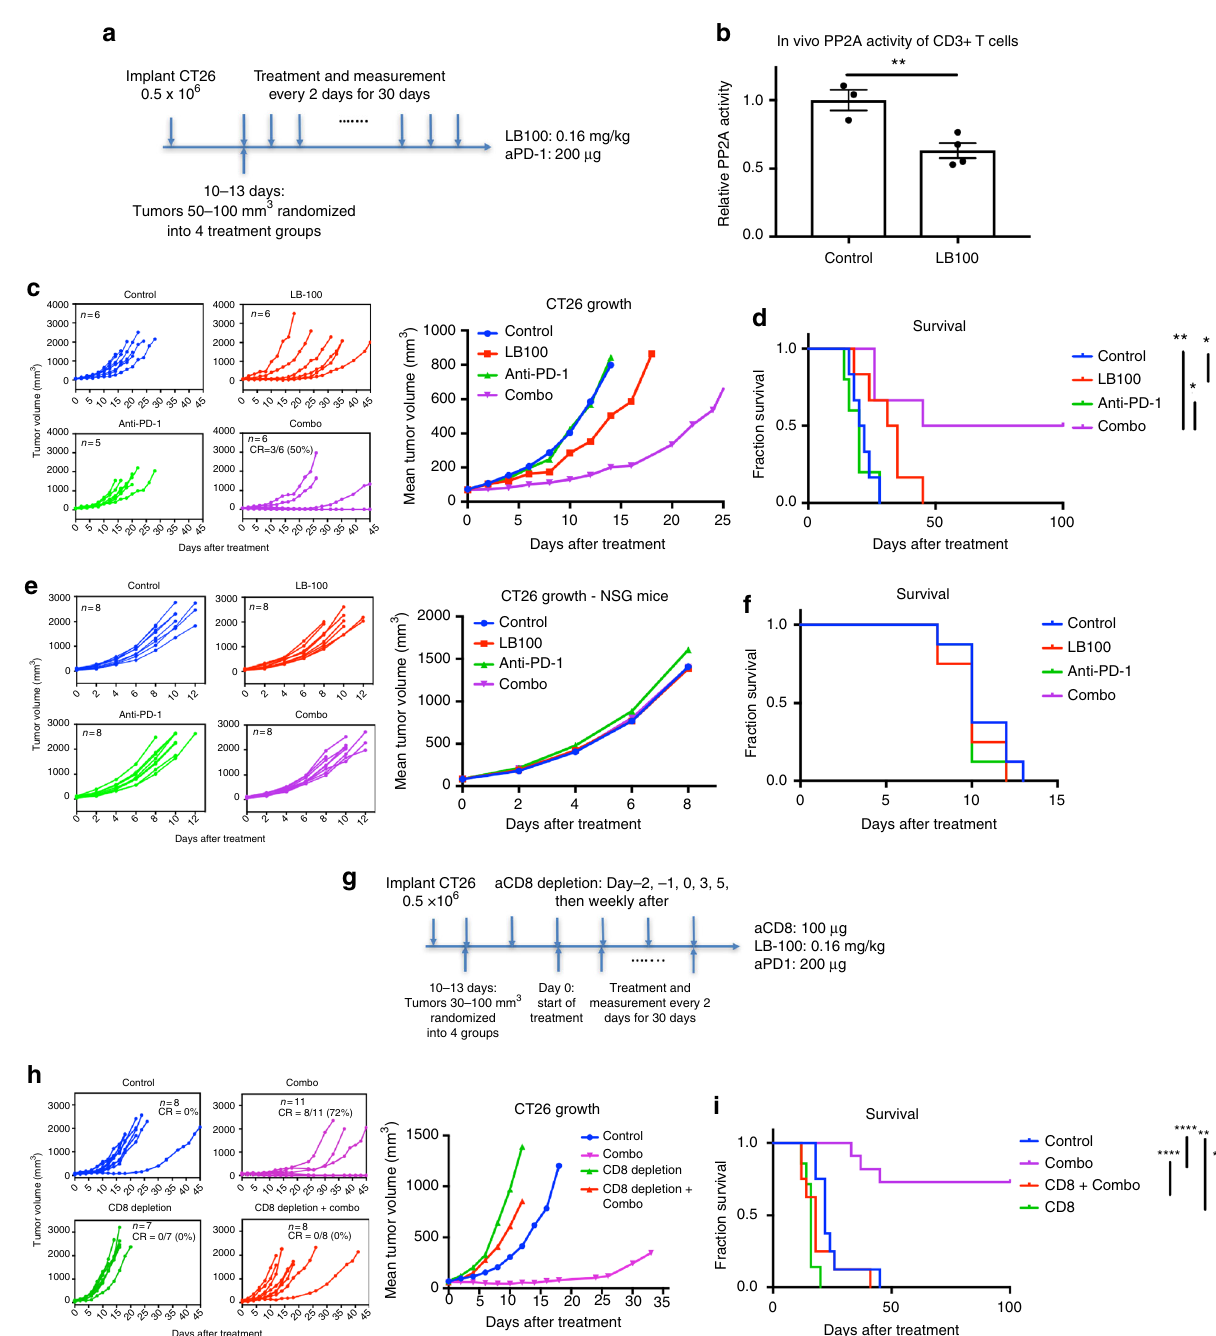
Fig. 1 PP2A inhibition and PD-1 blockade synergistically elicit tumor rejection in a CD8 + T cell-dependent manner. a BALB/c mice were inoculated with 0.5 × 10 6 CT26 cells subcutaneously in the right thoracic fl ank. When tumors reached between 50 and 100 mm 3 , mice were then randomized to four treatment groups and treated every 2 days until reaching survival end point. b BALB/c mice were treated with PBS or LB-100, 0.16 mg kg − 1 , every other day. 4 h after the third injection, CD3 + T cells were isolated from the spleen. PP2A activity was measured relative to control ( n = 3 for control and n = 4 for LB-100 group). Error bars depict SEM. c Tumor growth curves: control (blue), LB-100 (red), aPD-1 (green), and combination (purple). Individual and mean tumor volume over time. d Cumulative survival of mice over time. e , f Effect of LB-100 is dependent on adaptive immunity. Immunode fi cient NSG mice without T, B, and NK cells were similarly inoculated with CT26 cells and randomized into four treatment groups as in a . e Tumor growth curves with individual and mean tumor volume over time. f Cumulative survival of mice over time. g – i Synergy of LB-100 with PD-1 blockade is dependent on CD8 + T cells. BALB/c mice were inoculated similarly as above. g When tumors reached 30 – 100 mm 3 , mice were temporarily depleted of CD8 + T cells and treated with combination. h Tumor growth curves: control (blue), combination (purple), CD8 depletion only (green), and combination with CD8 depletion (red). Individual and mean tumor volume over time. i Cumulative survival of mice over time. Data are representative of two independent experiments. * P < 0.05, ** P < 0.01, and **** P < 0.0001 (log-rank test)